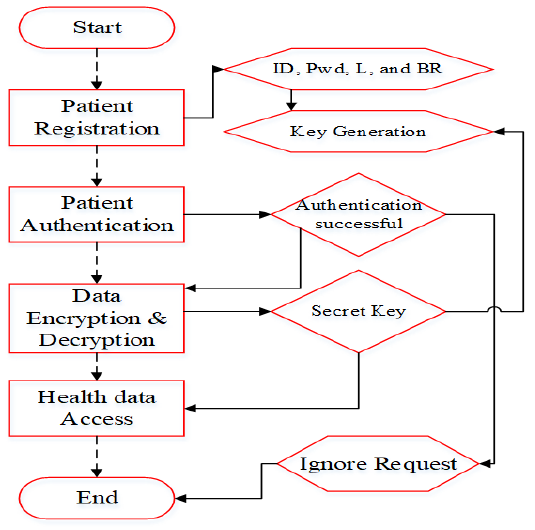
Figure 2. Security evaluation for